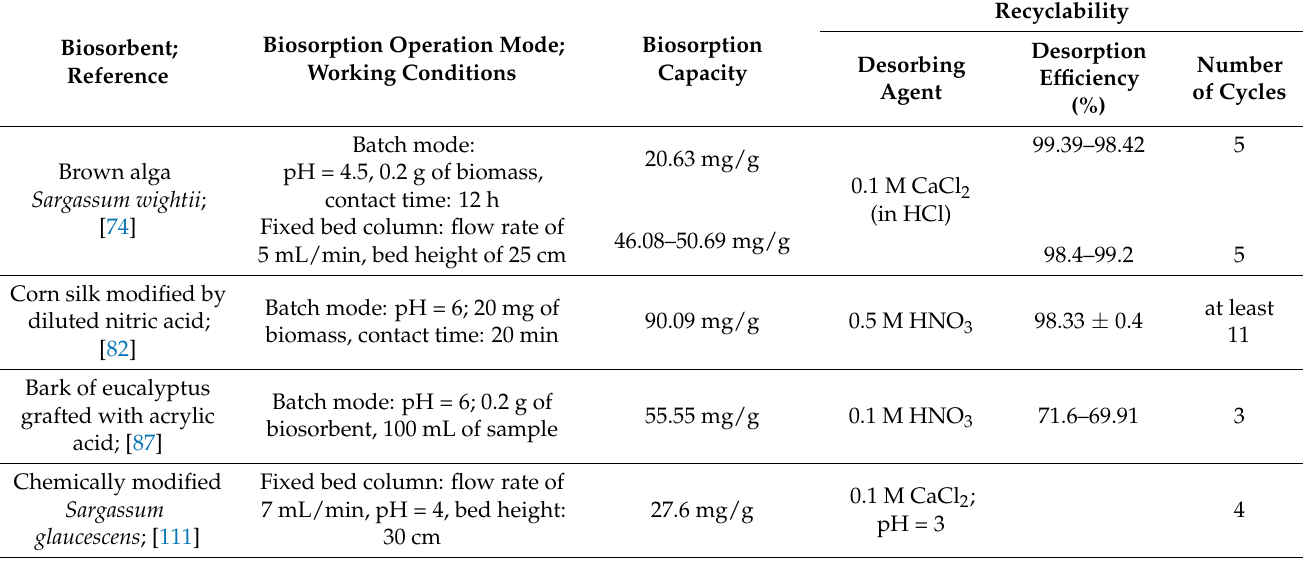
Table 3. Selected potential biosorbents for Co(II) sequestering from mono-element aqueous